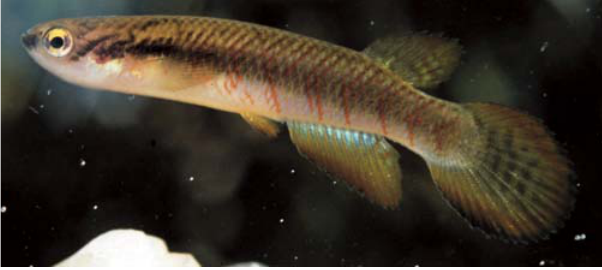
Fig. 1. Rivulus dapazi , UFRJ 5915, male, holotype, 24.3 mm SL (minutes after collection); Brazil: Mato Grosso do Sul: Sonora. Photo by W. J. E. M.